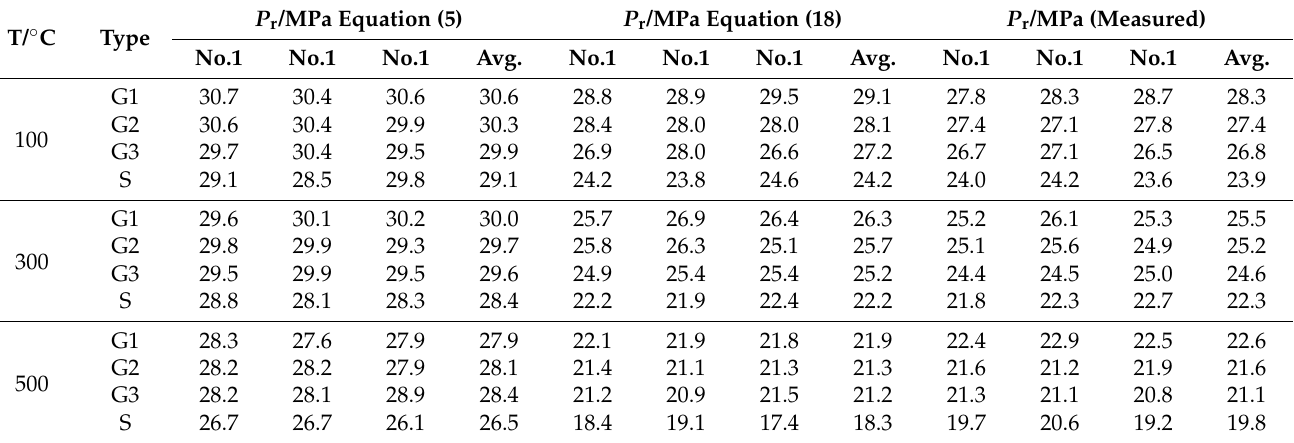
Table 2. Reopening pressure measured and calculated by Equations (5) and (18) at various tempera- tures and